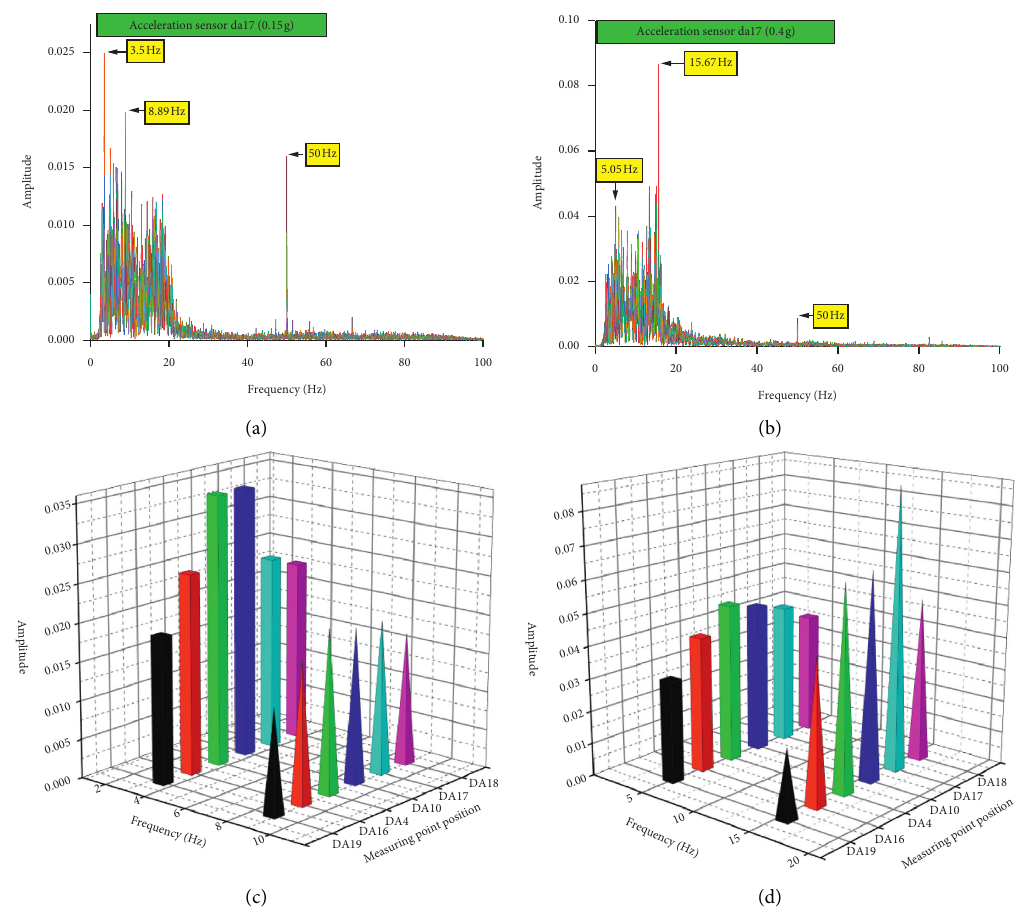
Figure 15: Excellent frequency of selected measuring points under different cases. (a) Spectrum curve of DA17 (0.15g). (b) Spectrum curve of DA17 (0.4g). (c) Excellent frequency of selected measuring points (0.15g). (d) Excellent frequency of selected measuring points